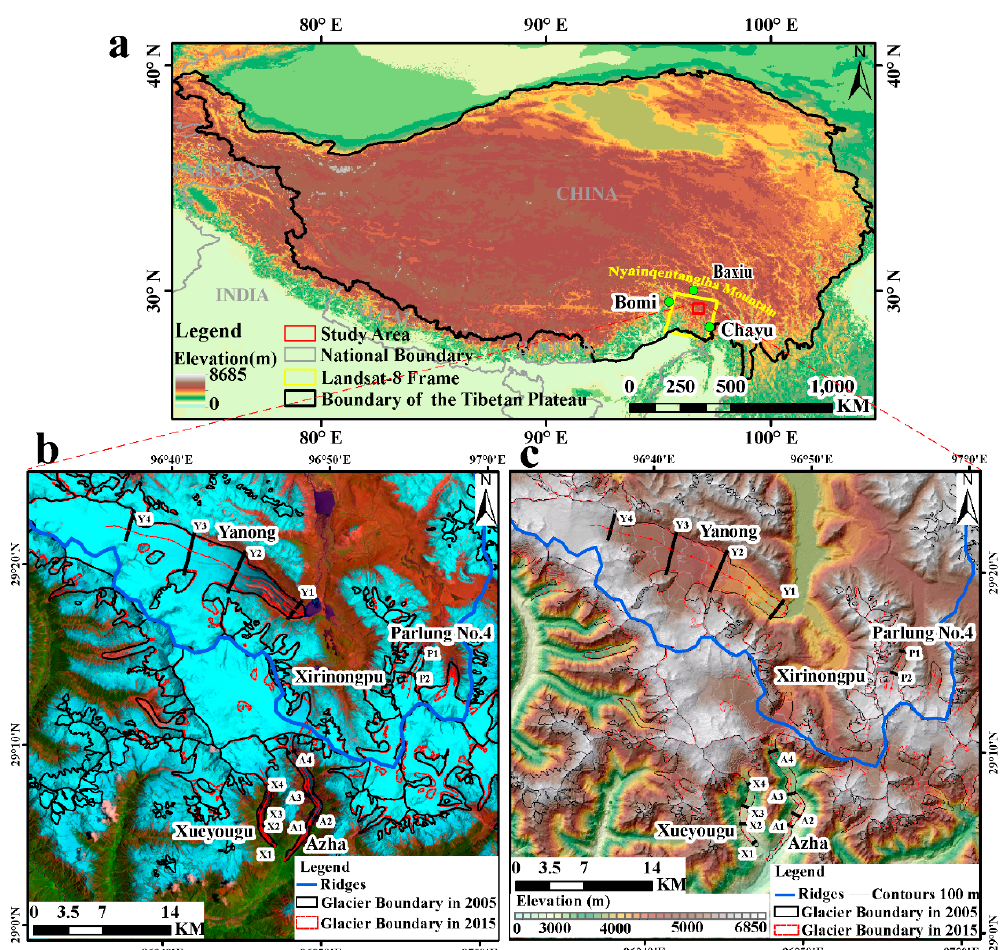
Figure 1. SRTM (Shuttle Radar Topography Mission) terrain elevation at 30 m × 30 m spatial resolution and location map of the study area: ( a ) Geographical location of the studied area (red rectangle) in the Tibetan Plateau, including glacier distribution and meteorological stations (green dots); ( b ) study area on a Landsat-8/OLI image on 25 May 2013 false-color composite with RED = band 7, GREEN = 5, and BLUE = 3; ( c ) elevation map of the study area.